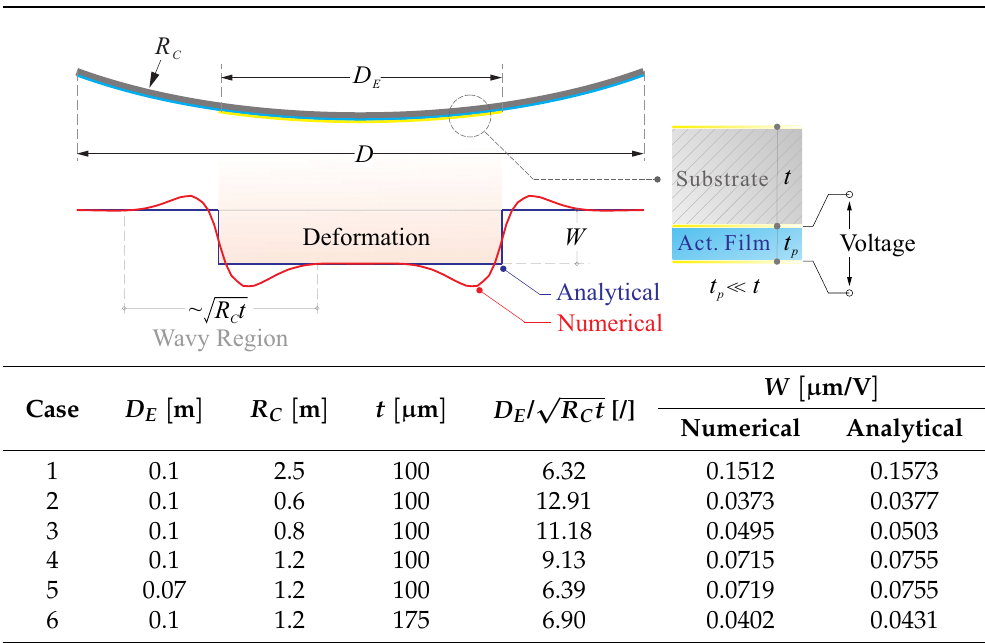
Table 1. Comparisons between numerical and analytical calculations of Equation (11) with a large √ R C t electrode of D E > 5.9